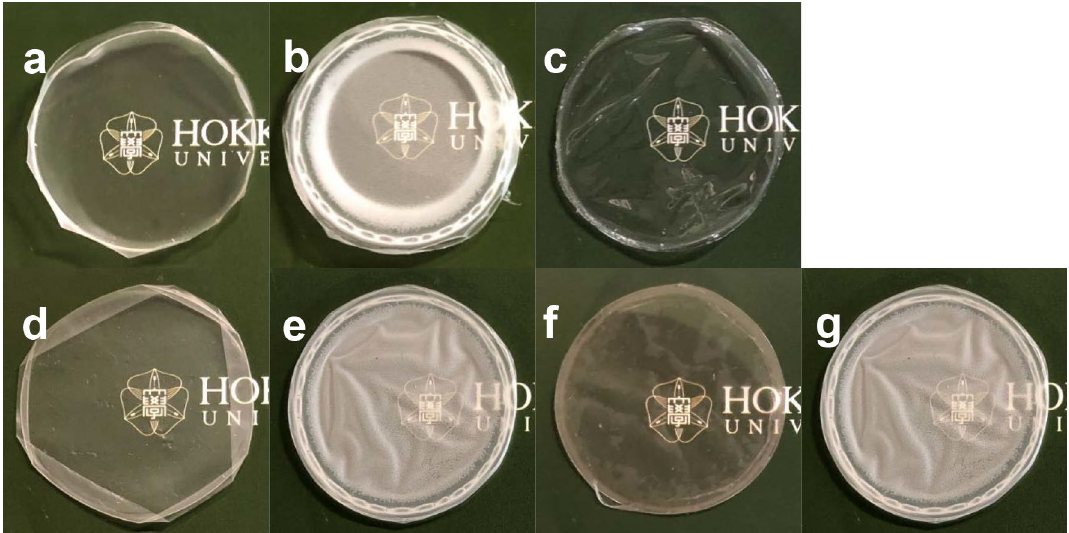
Figure 2. Films of the block and random copolymers of 2HB and 3HB. ( a ) solvent-cast film of P(88 mol% 2HB- b -3HB); ( b ) solvent-cast film of P(46 mol% 2HB- b -3HB); ( c ) solvent-cast film of P(92 mol% 2HB- ran - 3HB); ( d ) film of P(88 mol% 2HB- b -3HB) after annealing at 70 °C for 24 h; ( e ) film of P(46 mol% 2HB- b -3HB) after annealing at 70 °C for 24 h; ( f ) annealed and melt-quenched film of P(88 mol% 2HB- b -3HB); ( g ) annealed and melt-quenched film of P(46 mol% 2HB- b -3HB). Diameter of the films is approximately 4.8 cm.